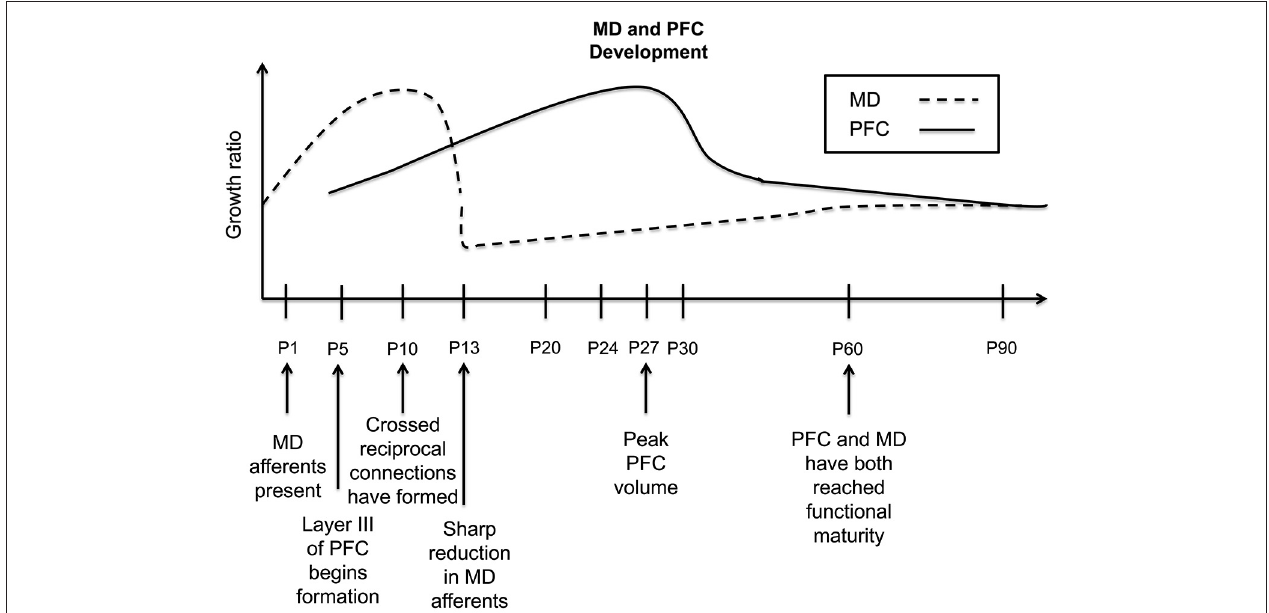
around P27, dropping rapidly around P30, and then decreasing gradually until P90. Given that the PFC volumetric changes follow closely behind the density dynamics of inputs from the MD, this may suggest a regulatory relationship of MD innervation on PFC development. This summary graph is based on the previous publications (Van Eden and Uylings, 1985; Van Eden, 1986; Rios and Villalobos,